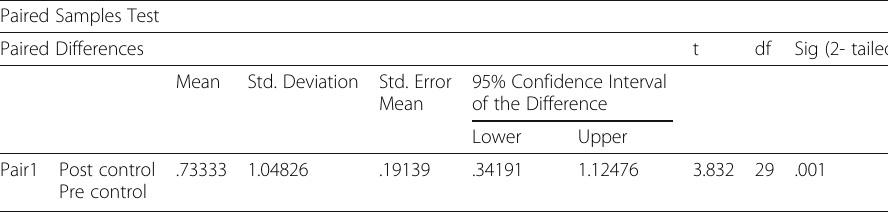
Table 10 Paired Samples Test of the Control Group (non-DA-based) Paired Samples Test Paired